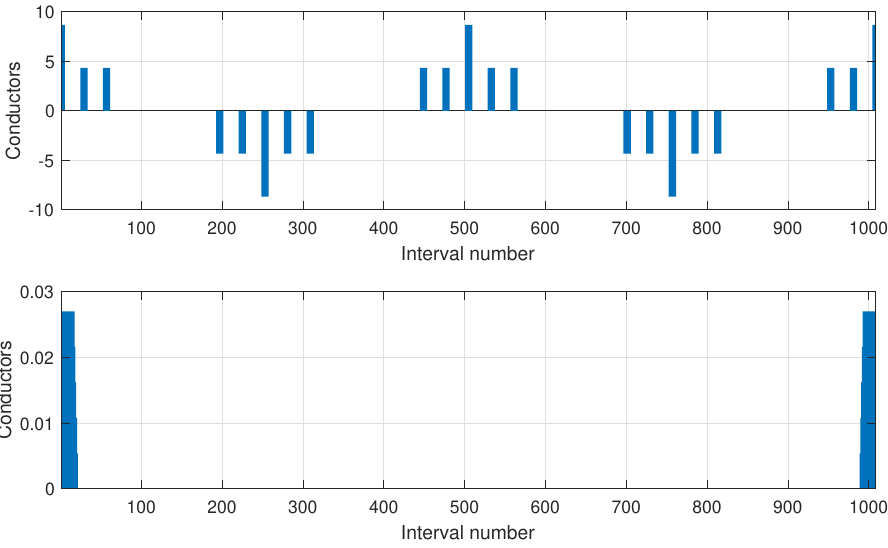
Figure 12. Distribution of the conductors of a stator phase ( top ) and a rotor bar ( bottom